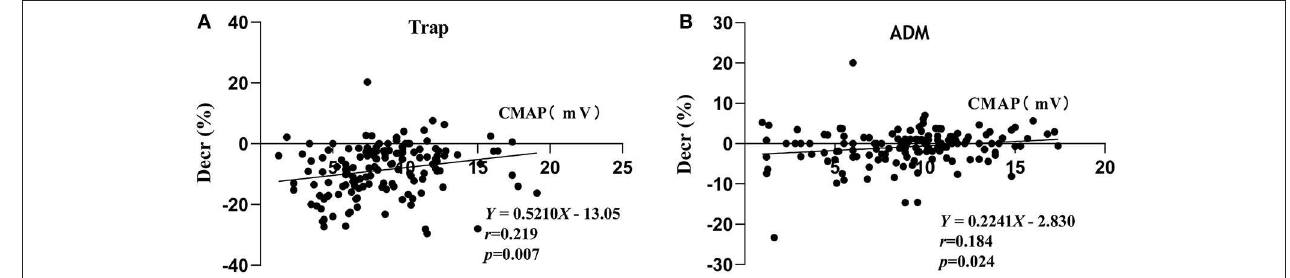
FIGURE 2 | Correlations between the CMAP amplitude and decremental percentages in TRAP (A) and ADM (B) . Decr(%), percentage of decremental response; CMAP, compound muscle action potential; Trap, trapezius muscle; ADM, abductor digiti minimi.